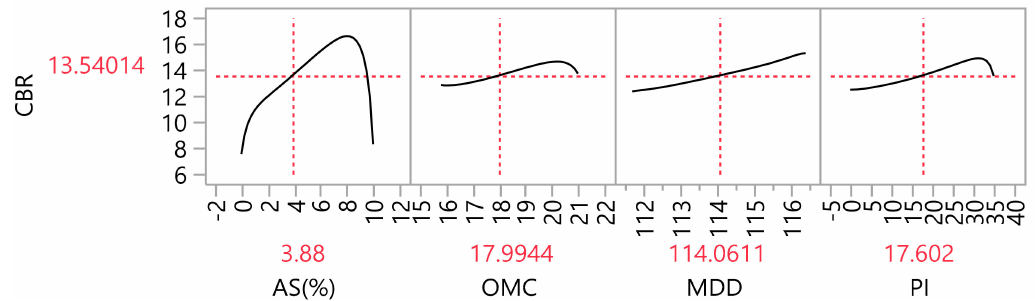
Figure 6. Variable Analysis